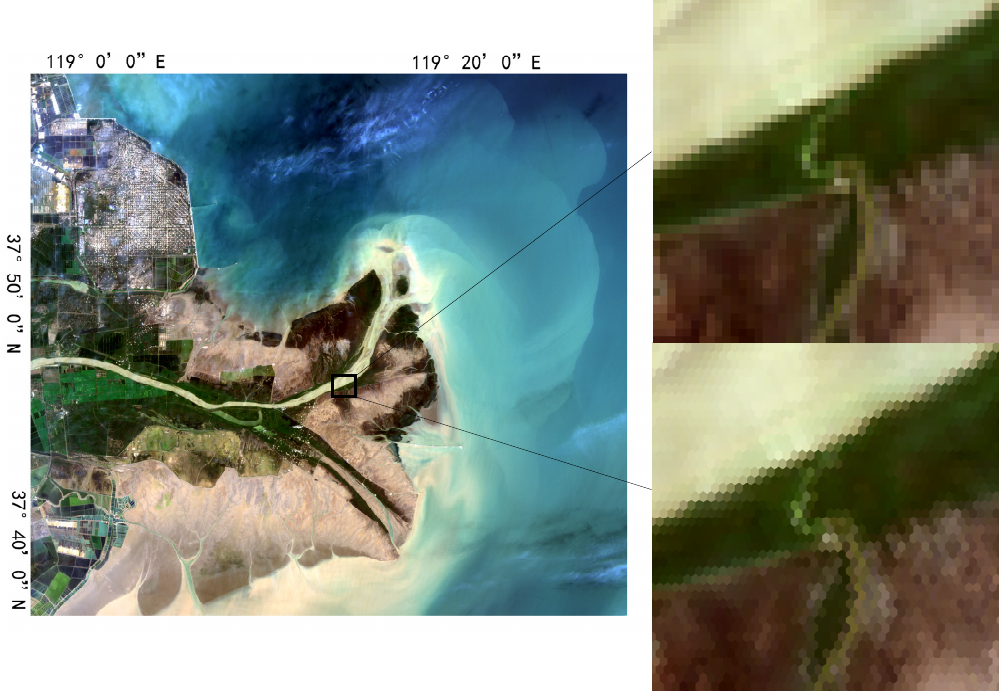
Figure 11. Expression of a Landsat 8 image based on hexagonal grids and rectangular pixels.